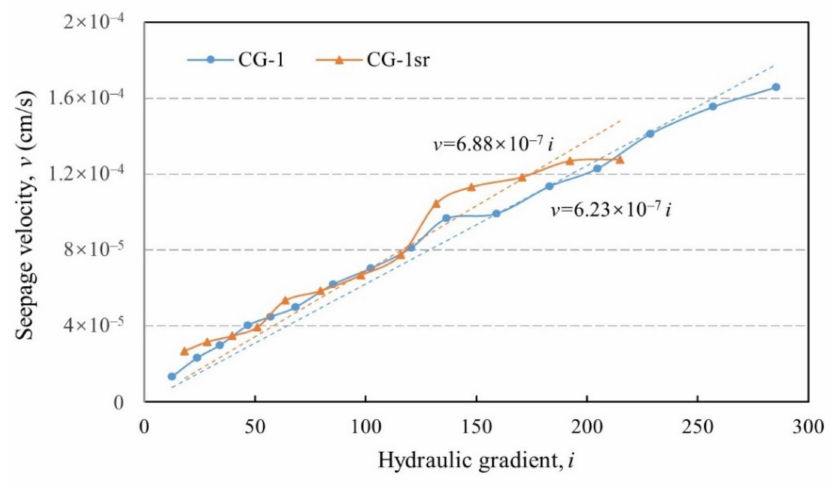
Figure 9. v–i relationships under triaxial stress state ( σ x = σ y = 2.5 MPa, σ z = 2